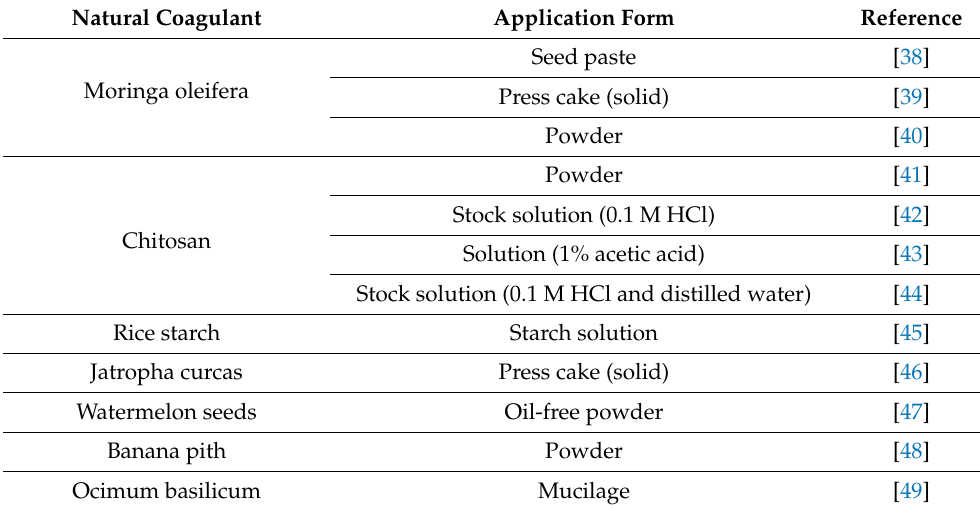
Table 1. The main application forms of natural